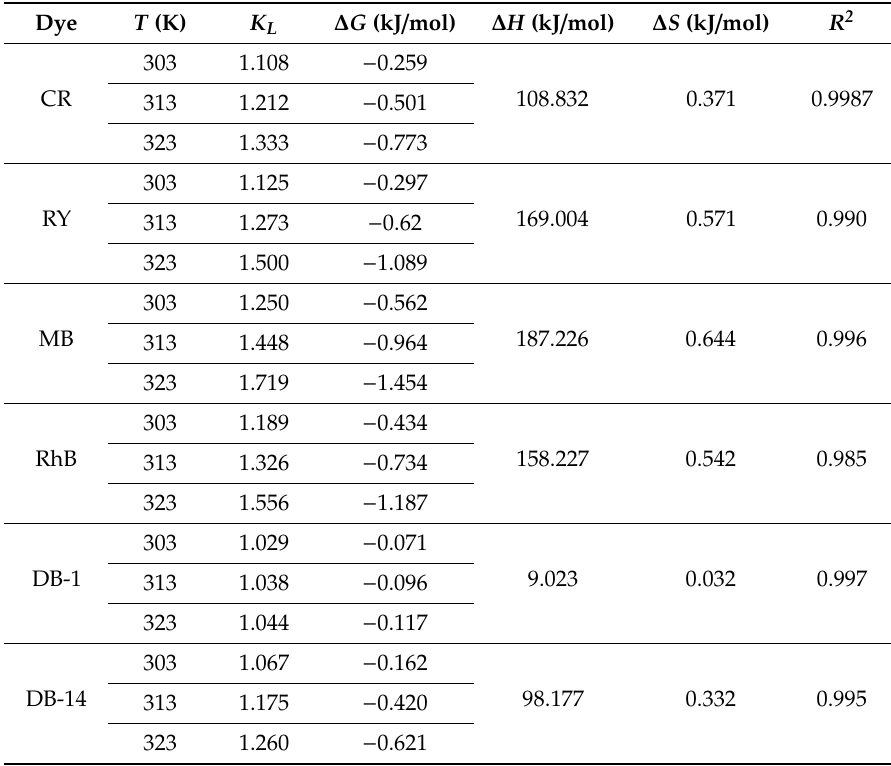
Table 4. Thermodynamic parameters of studied